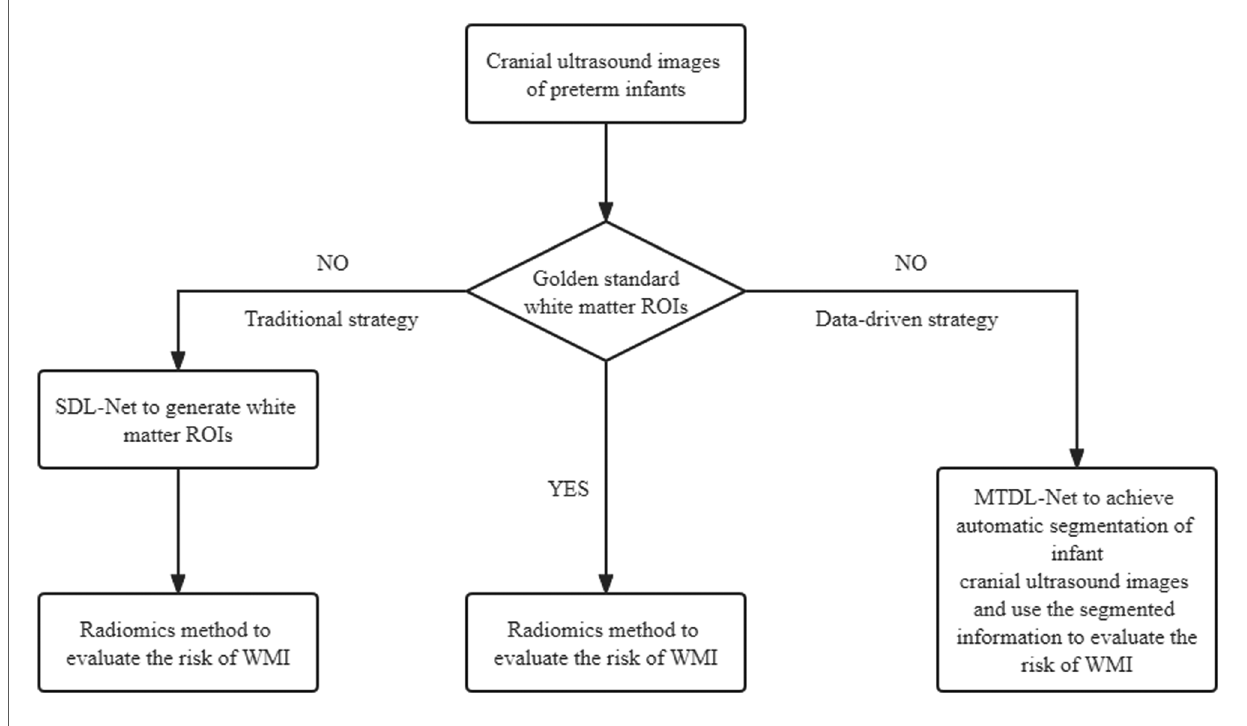
FIGURE 11 Overview of our data-driven diagnostic